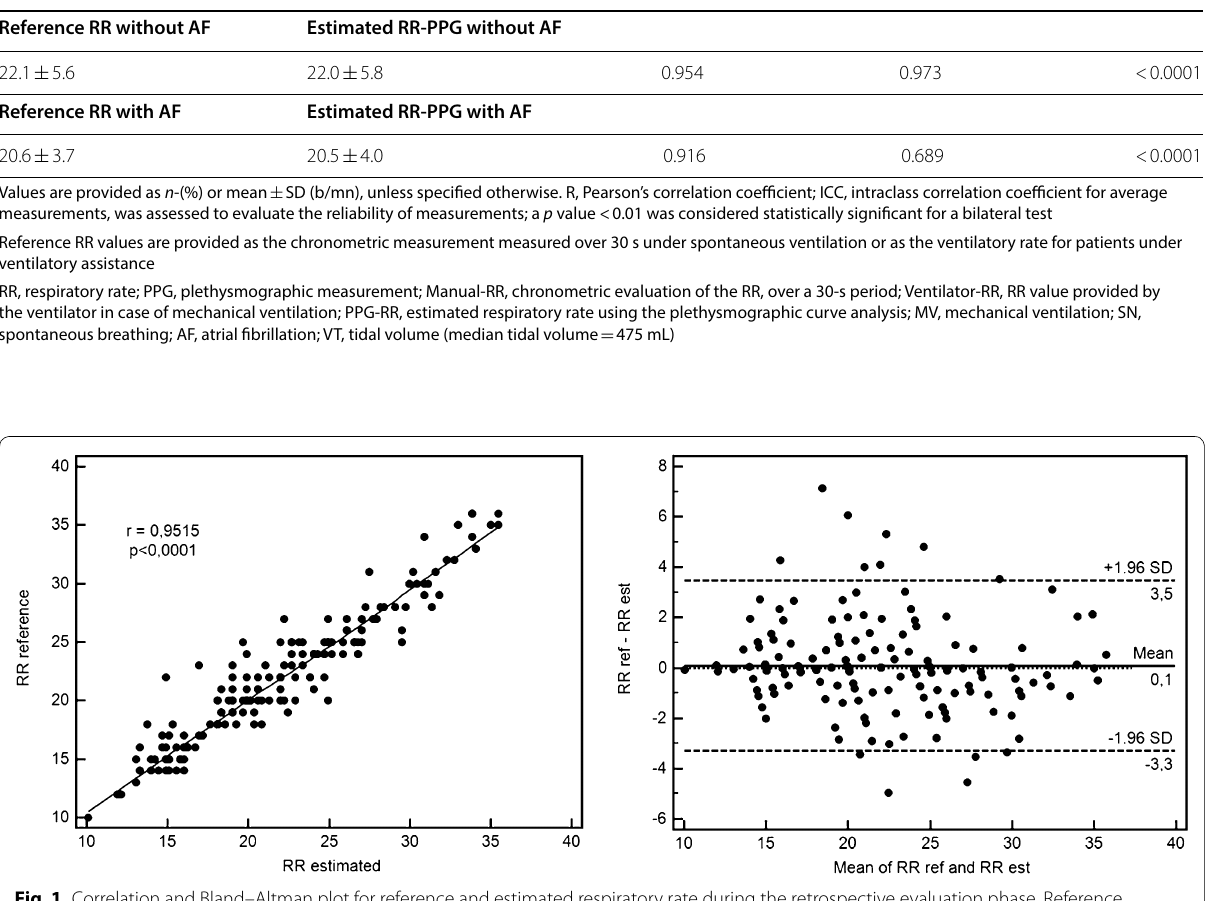
0.95; p < 0.0001). Comparison of the = 3.5 ±